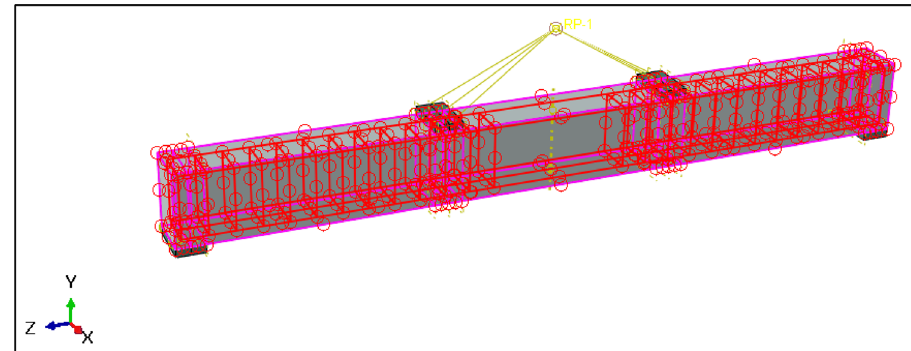
Figure 3: Interaction of